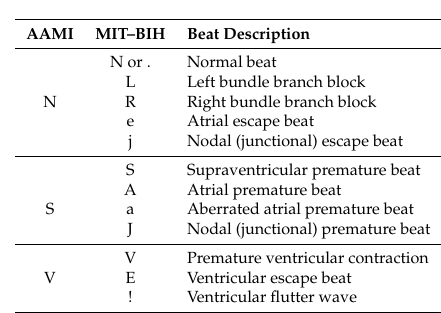
Table 1. Association for the Advancement of Medical Instrumentation (AAMI) to MIT–BIH annotation mapping